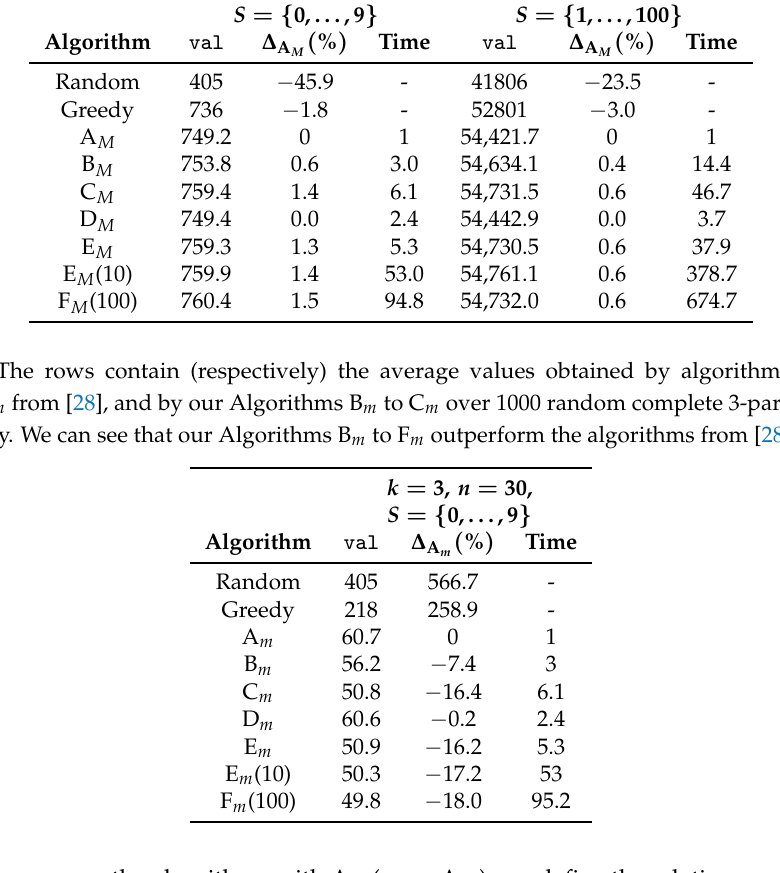
Table 1. Comparison of Random, Greedy and A M algorithms from [28] with B M to F M algorithms for the maximization version of 3-AP. Each row contains average values of solutions obtained by these algorithms, computed over 1000 random instances of complete k -partite graphs with n vertices, which are generated as described in Section 4.1. We can see that Algorithms B M to F M return substantially better results. k = 3, n = 30,